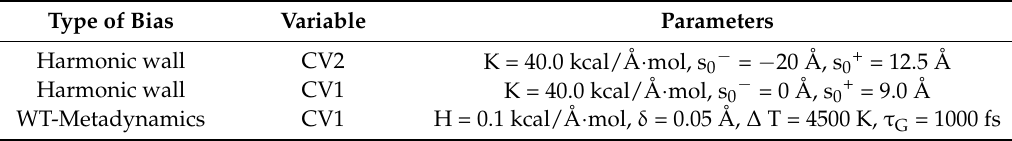
Table 2. Parameters of the metadynamics simulation for each of the